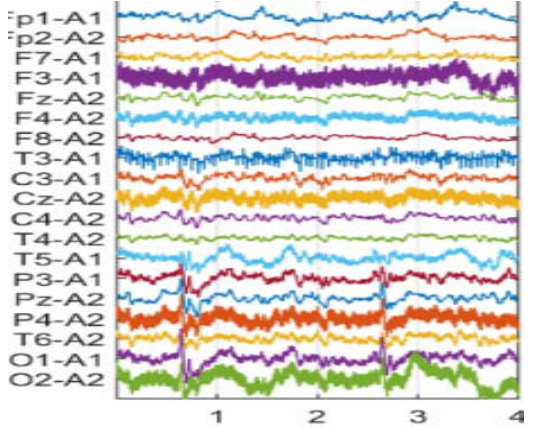
Fig. 3. The EEG activities for the first subject with epilepsy.